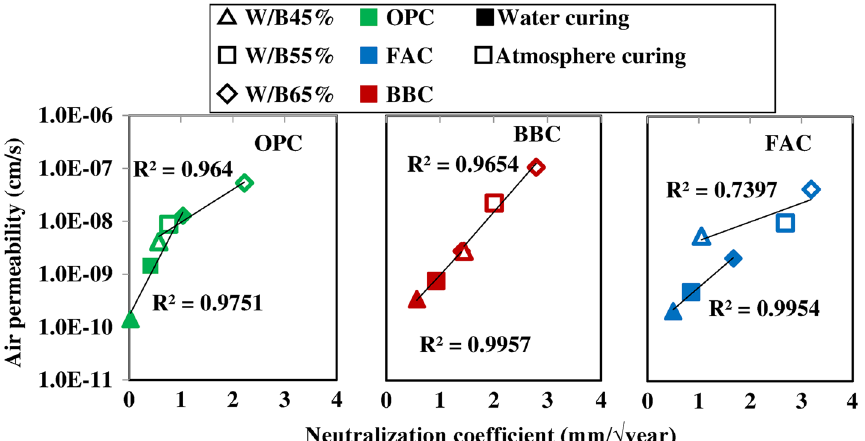
Fig. 5 Air permeability versus neutralization coefficient.